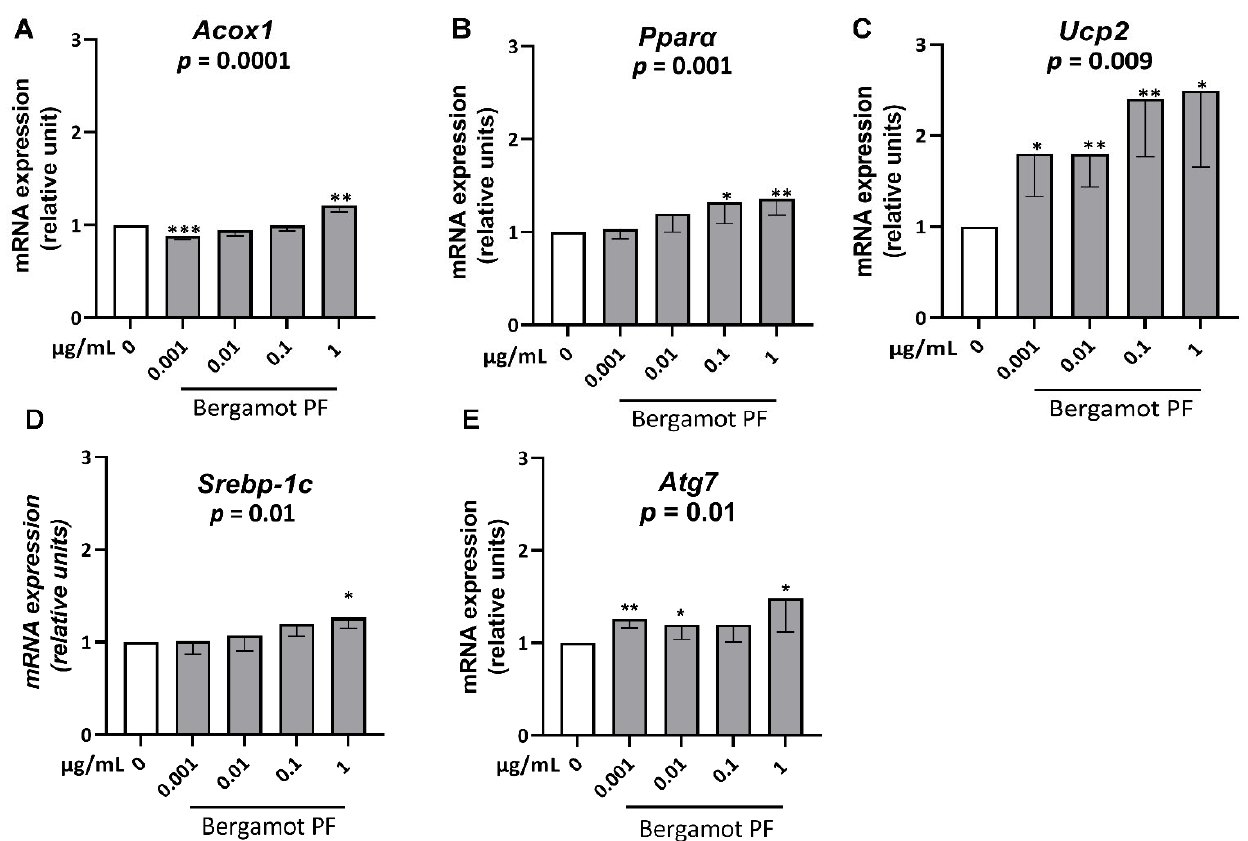
Figure 2. Bergamot PF extract increase regulates Acox1 , Ppar α , Ucp2 , Srebp-1c, and Atg7 mRNA expression levels in McA Rh-7777 cells. Semi-confluent cultures of rat hepatoma cell line (McA Rh-7777) were incubated with 50 µ M of oleic acid and different concentrations of BPF (0.001, 0.01, 0.1, ( B ) Ppar α , ( C ) Ucp2 , ( D ) Srebp-1c , and ( E ) Atg7 were measured using real-time PCR. Data